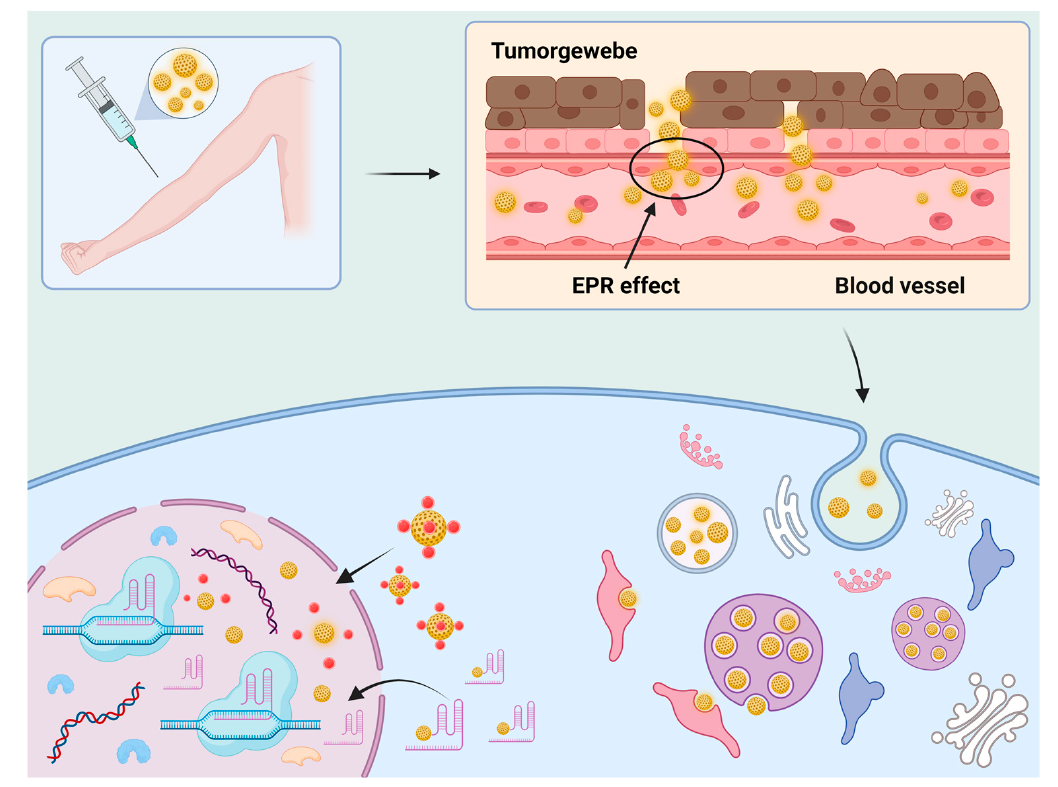
Figure 5. NPs accumulate at tumor sites through EPR effects and targeted delivery systems of NPs.